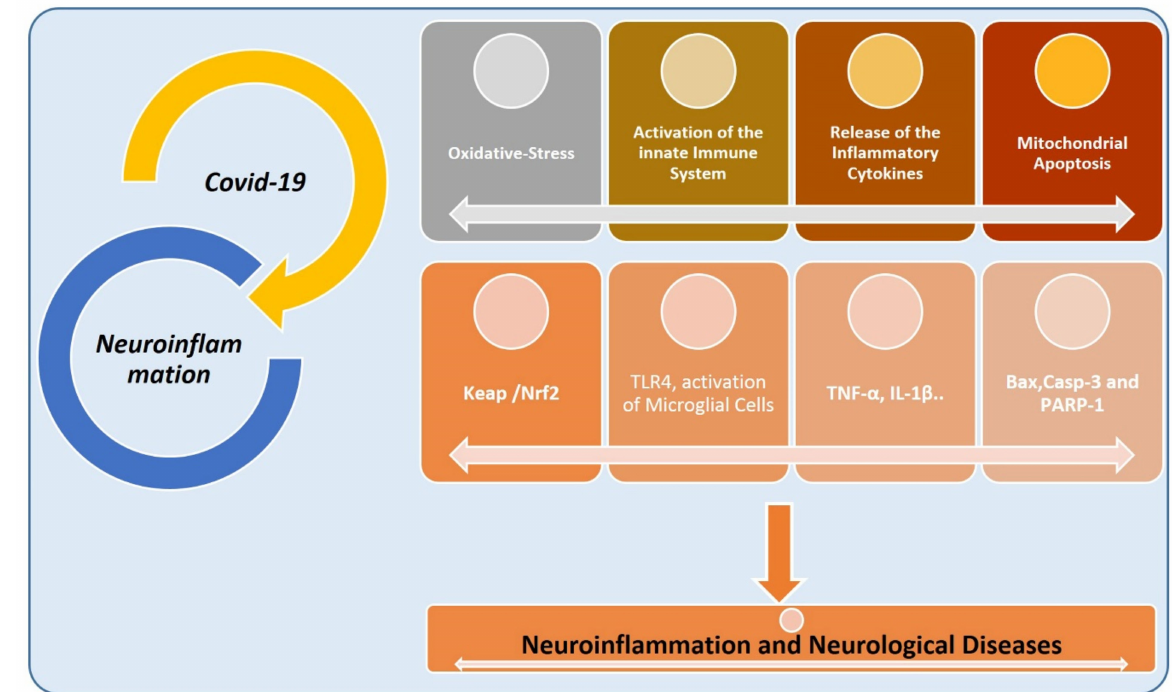
Figure 8. COVID-19 and